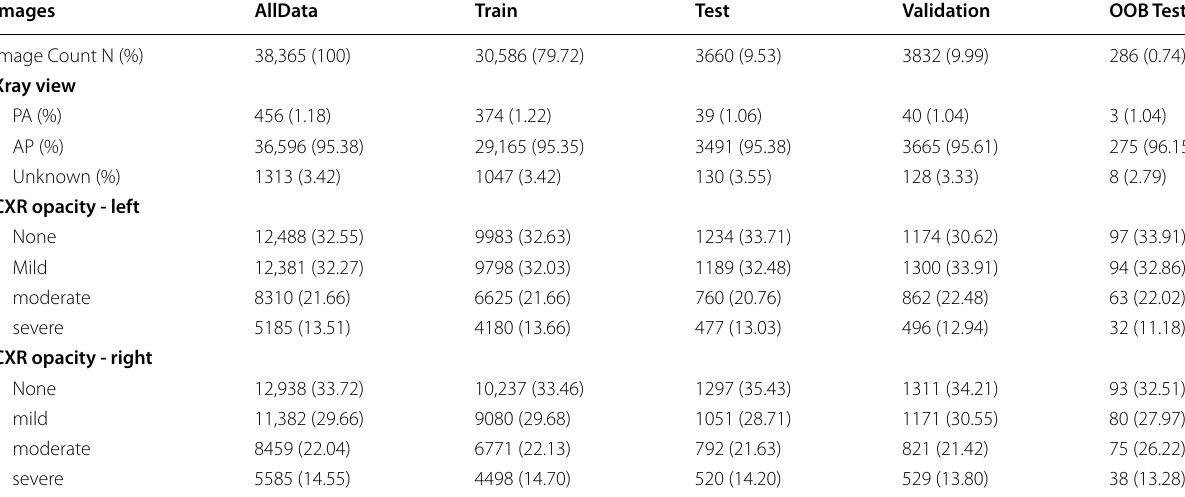
Image-wise demographics for CXR view and opacity